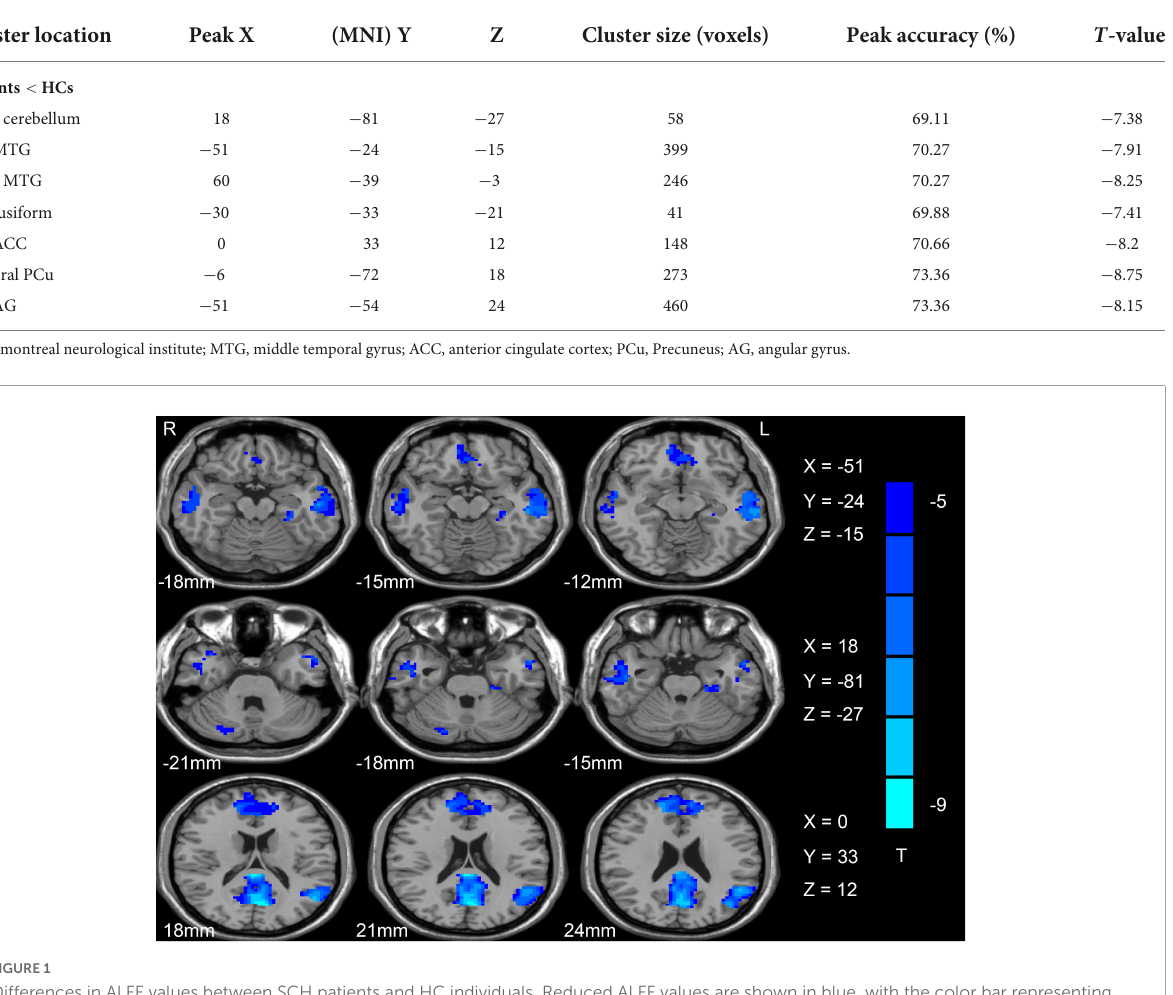
parietal lobule in non-depressed SCH individuals (41), while another study reported reduced ReHo in the right superior temporal gyrus, left middle frontal gyrus, PCu, and left